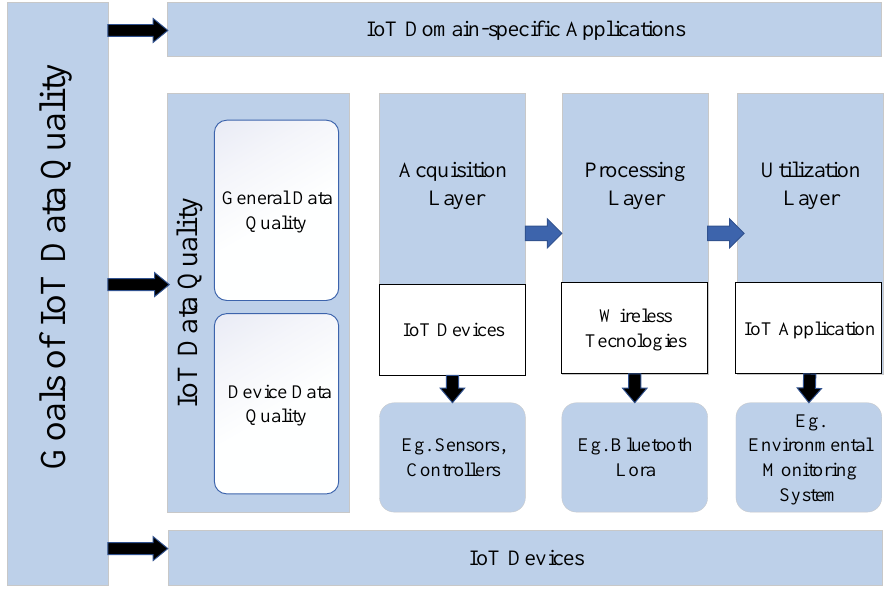
Figure 2. IoT DQ conceptual framework